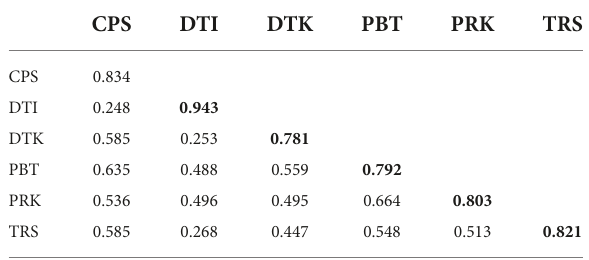
TABLE 3 Discriminant